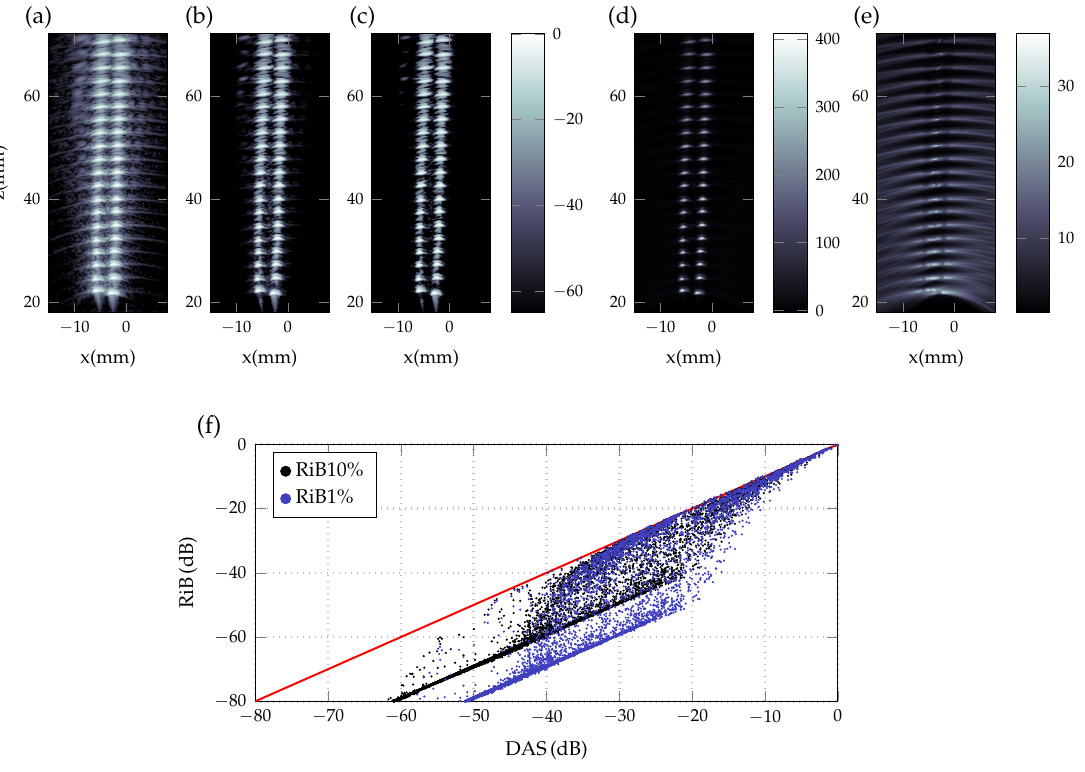
ε —Figure 4d—it is related to the structure reflectivity; and on the other, σ estimates—Figure 4e—to the interference zones caused by point sources. In this case it is shown how interferences contribute to lower lateral resolution on TFM-DAS –Figure 4a.